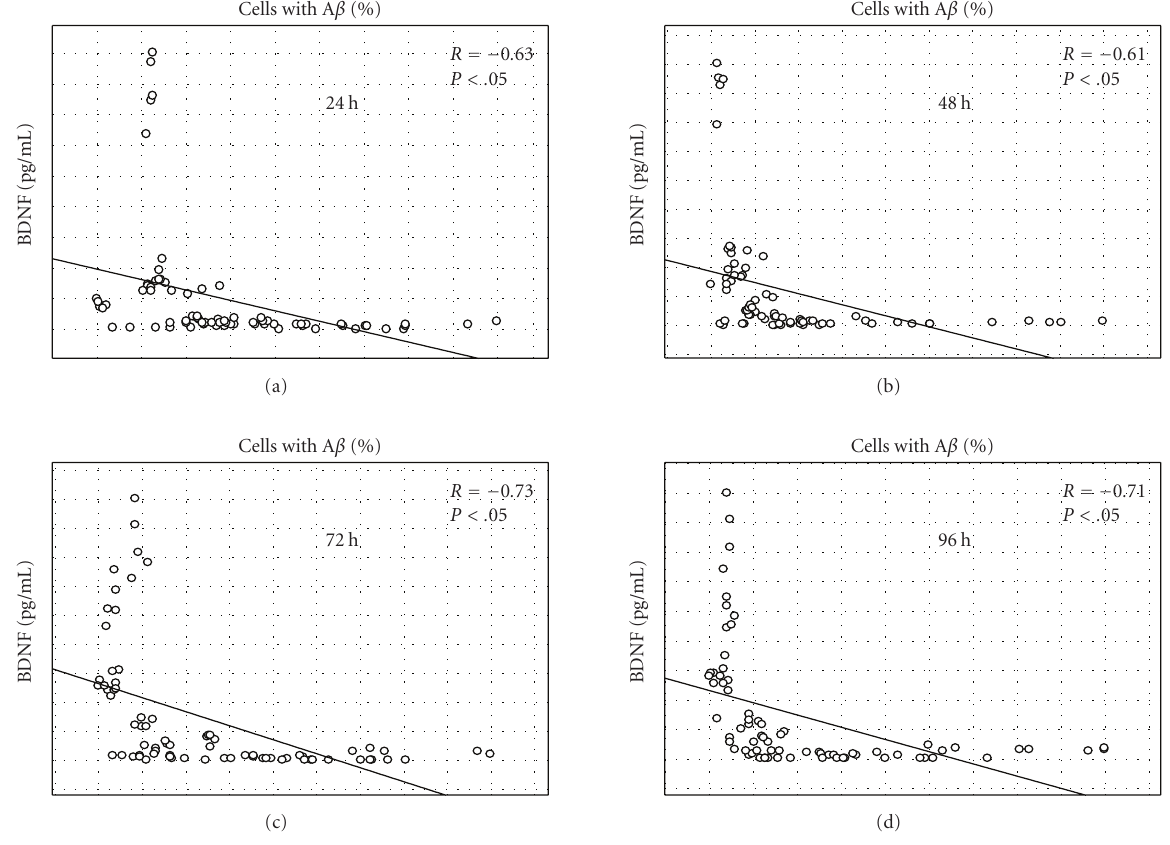
Figure 8: Correlation between the secretion of BDNF and the proportion of A β 1 – 42 + cells. The secretion of BDNF (pg/mL) and the proportion of A β 1 – 42 + cells in the Protollin series of experiments were analysed at each time point using Spearman’s Rank Order Correlations test. A significant negative correlation was found at all time points. A statistical significant correlation is indicated by ∗ ( P < .